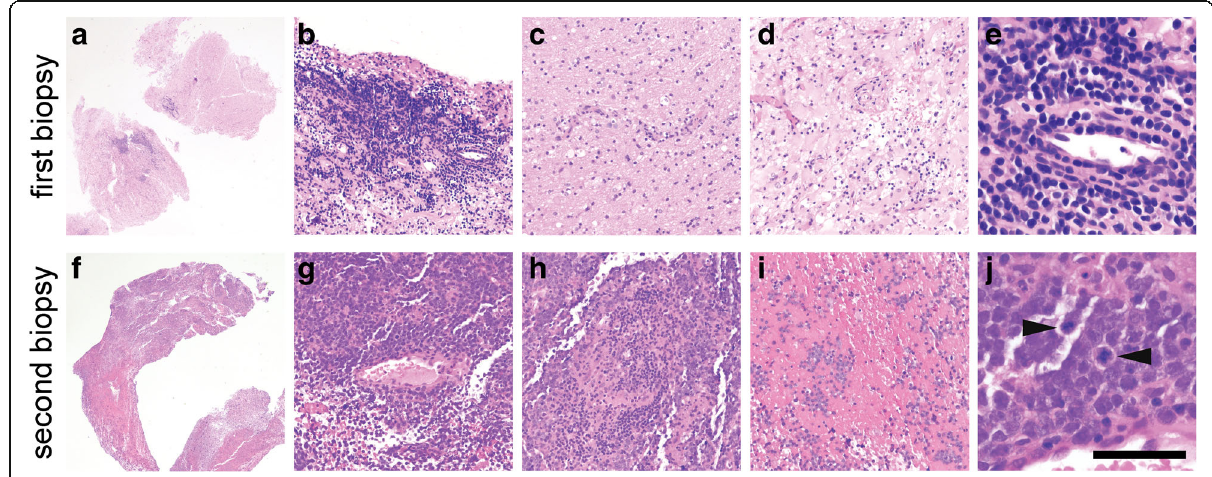
Fig. 2 Hematoxylin and eosin ( H & E ) features of both biopsies. In the first biopsy of the right basal ganglia lesion ( a , e ), abundant mature- appearing lymphocytes were present in a mostly perivascular distribution. In the second biopsy of the left middle cerebellar peduncle lesion ( f - j ), there were sheets of neoplastic cells with large nuclei and numerous mitoses (j, arrowheads). Scale bar = 2 mm in a & f, 200 μ m in b-d and g-i, and 50 μ m in e & j